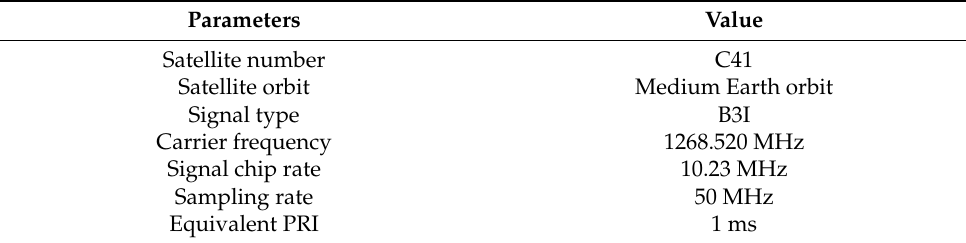
Table 2. Experimental parameters.